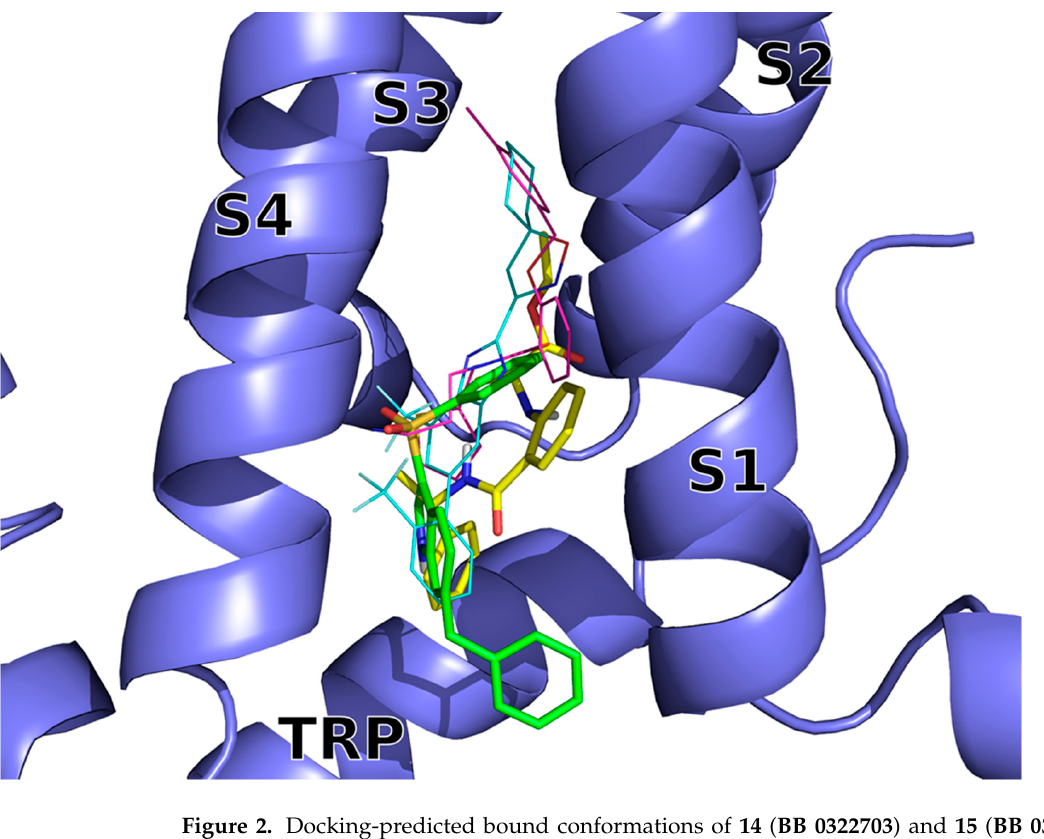
Figure 2. Docking-predicted bound conformations of 14 ( BB 0322703 ) and 15 ( BB 0322720 ) into hTRPM8 723–1013 . hTRPM8 is represented in blue cartoons. 14 ( BB 0322703 ) and 15 ( BB 0322720 ) in their hTRPM8-bound conformations are represented in yellow and green thick sticks, respectively. TC-I 2014 (PDB ID: 6O72) and AMTB (PDB ID: 6O6R) experimental bound conformations are shown in cyan and magenta thin sticks, respectively, for reference.